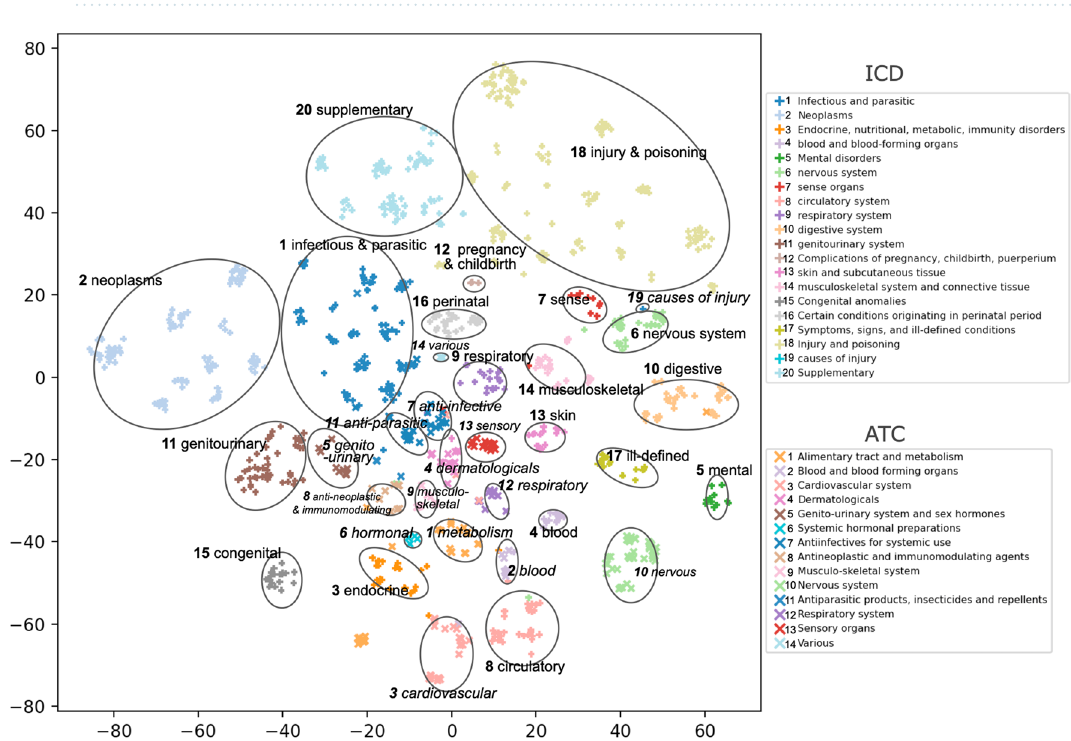
Figure 7. Top 5 EHR codes of the 5 select topics for a diverse set of conditions. The top 5 ICD and ATC codes were displayed for the same topics in the two separate heatmaps. The heatmap intensity is proportional to the probabilities of each code under the topic. The color bar on the left of each heatmap indicates the first-level category of the corresponding code.